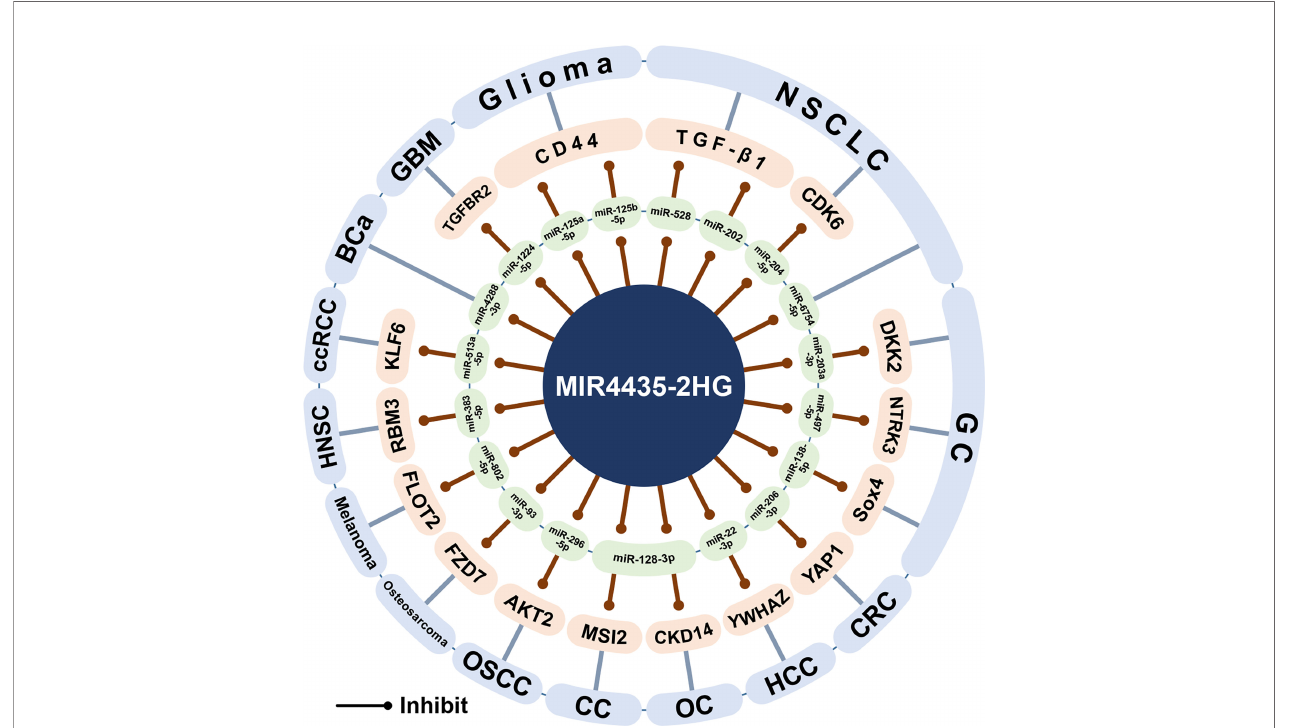
FIGURE 6 | The ceRNA network of MIR4435-2HG. MIR4435-2HG can interact with 19 miRNAs in at least 14 cancers and osteoarthritis, and regulate the expression of its downstream target genes. HCC, Hepatocellular carcinoma; CRC, Colorectal cancer; OSCC, Oral squamous cell carcinoma; GC, Gastric cancer; NSCLC, Non-small cell lung cancer; GBM, Glioblastoma; BCa, Bladder cancer; ccRCC, clear cell renal cell carcinoma; OC, Ovarian cancer; CC, Cervical cancer; HNSC, Head and neck squamous cell